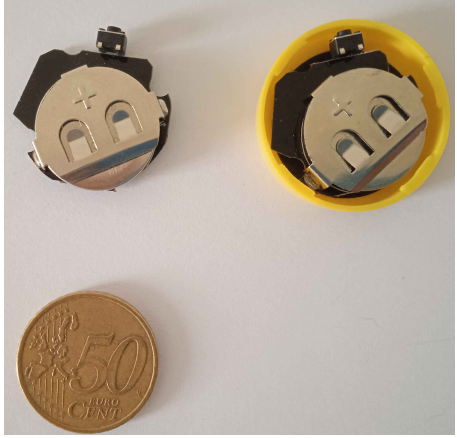
Figure 5. Bluetooth tags used during our experiments.